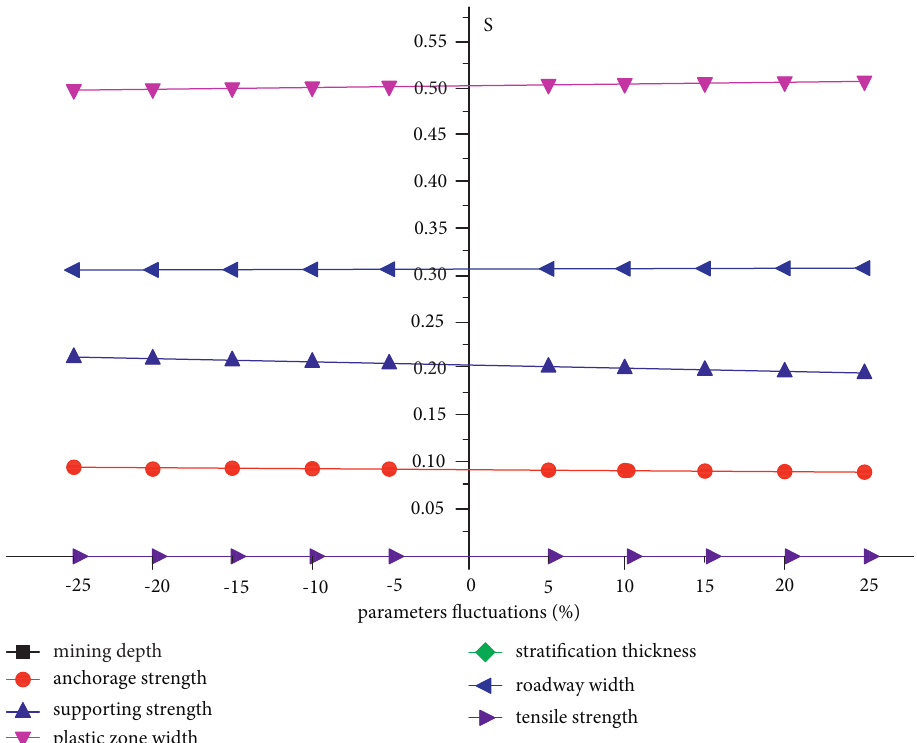
Figure 6: Relationship between the rate of change of each parameter and